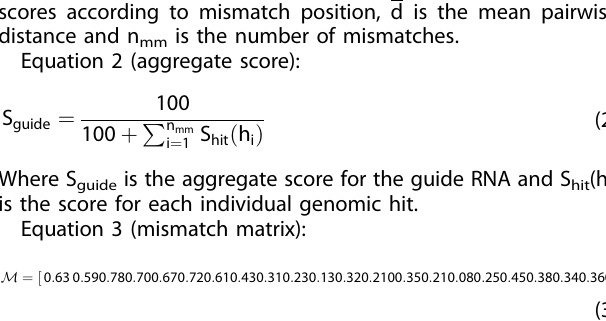
In an attempt to maintain similar repression strengths between different CRISPRi promoters, only gRNA spacer sequences with predicted hybrid gRNA-spacer/cognate-DNA binding free energies with a speci fi ed range were retained. Hybrid DNA-RNA free energies were calculated using MELTING 38,39 .